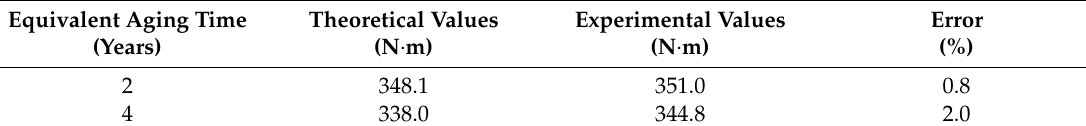
Table 3. The theoretical and experimental values of the ultimate bending moment.